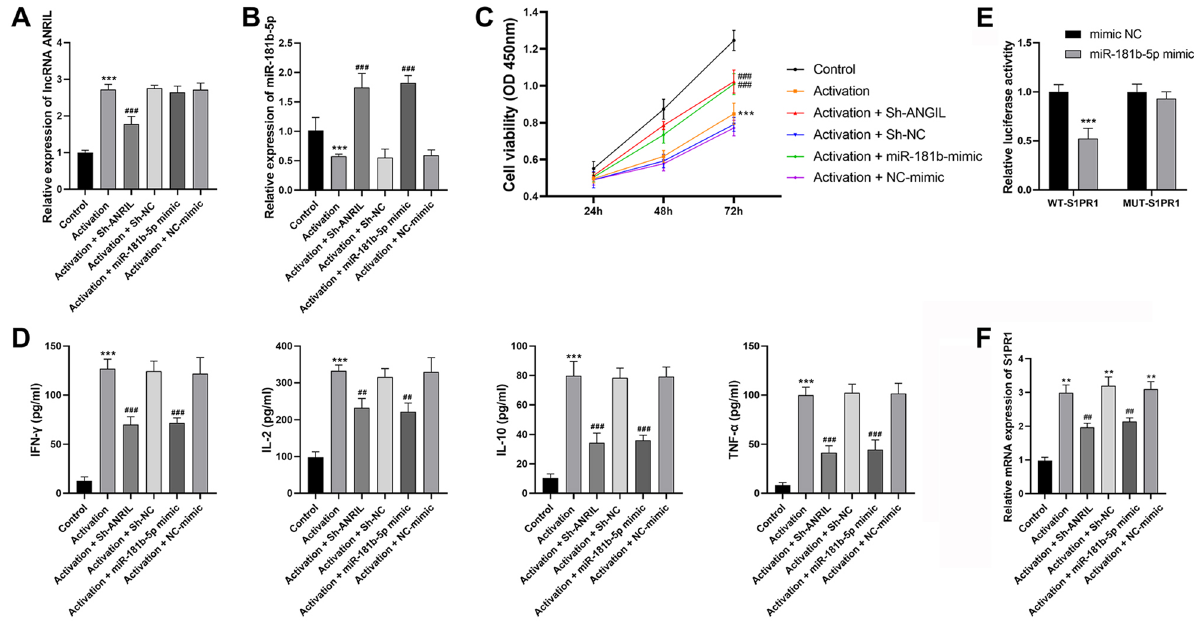
Figure 3. The regulatory effects of ANRIL/miR-181b-5p on T cell activation in vitro ( A ) qRT-PCR of ANRIL expression; ( B ) qRT-PCR of miR-181b-5p expression; ( C ) CCK-8 assay of cell viability; ( D ) ELISA of inflammatory parameters (IFN-γ, IL-2, IL-10, and TNF-α); ( E ) DLR assay of the target relationship between miR-181b-5p and S1PR1; ( F ) qRT-PCR of ANRIL expression. **P < 0.01, ***P < 0.001 vs. control ( A – D , F ) or mimic NC ( E ); ## P < 0.01, ### P < 0.001 vs. activation. Data was analyzed using t test or one-way analysis of variance (ANOVA) followed by Tukey’s